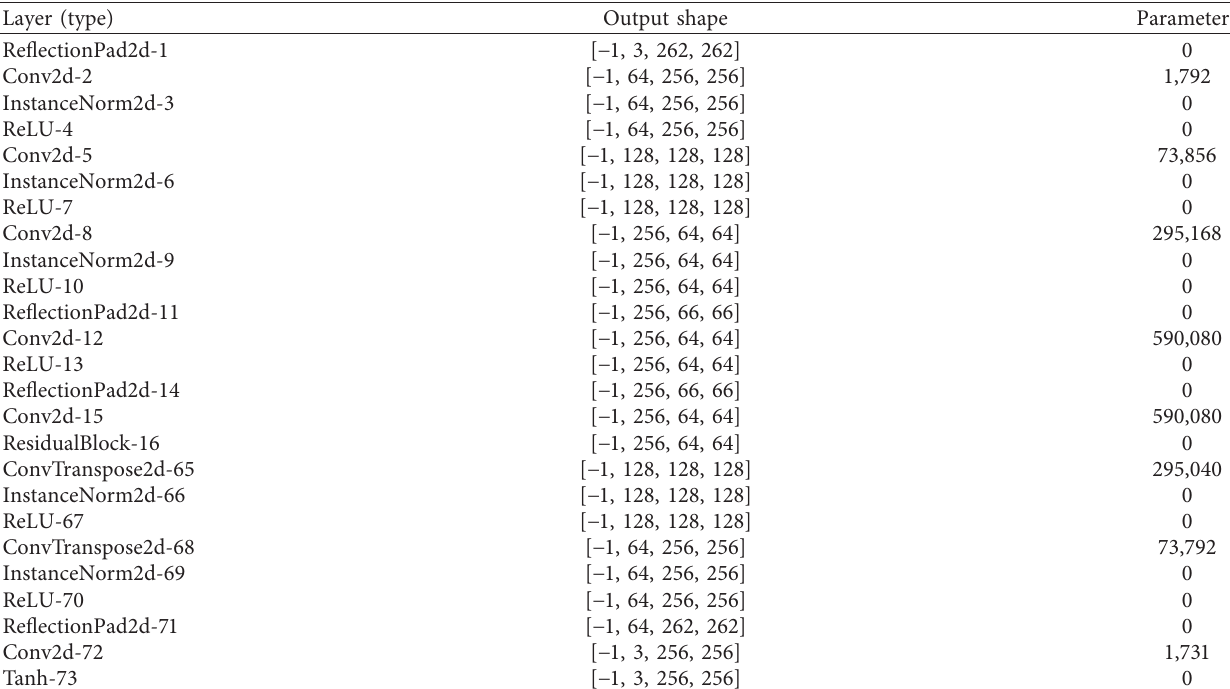
Table 1: The layer structure and parameters of the